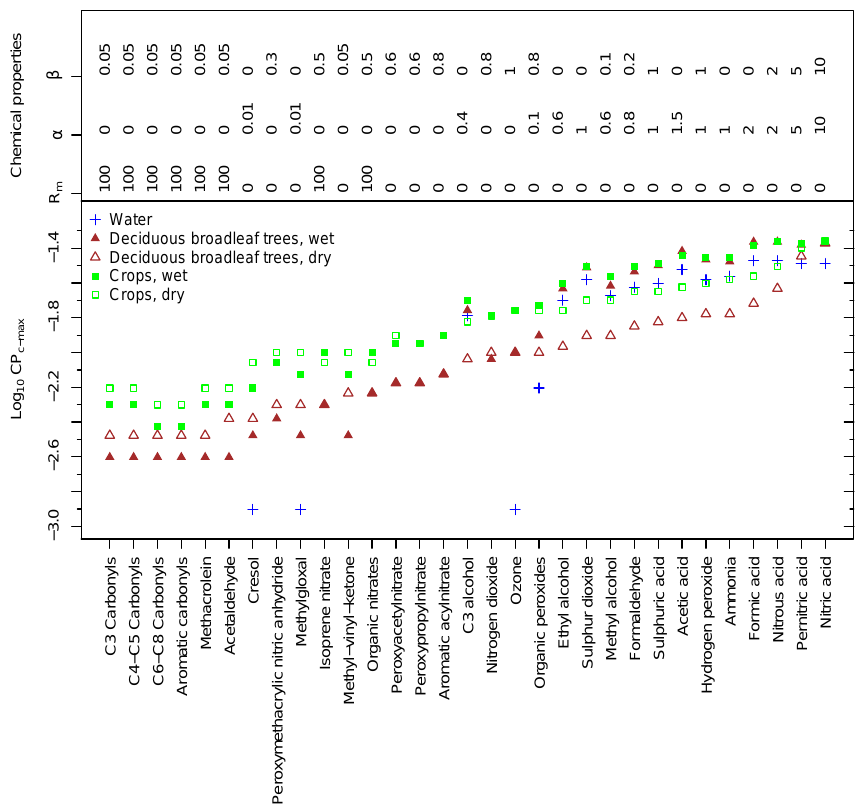
Fig. 5. Maximum values of the chemical parameter, CP c − max , computed as in Eq. (35) for deposition of chemicals to land surface types and to water, using maximum deposition velocities given by Zhang et al. (2003). Parameters α and β are scaling factors based on aqueous solubility and half-redox reactivity, respectively, and R m is the mesophyll resistance in sm − 1 with values from Zhang et al. (2002). with samplers at z 2 = 10 and z 1 = 1 m. At the 15-, 30-, and 60-km fetch stations, z/L = 0.12, 0.70, 1.03, | 1C | = 70,